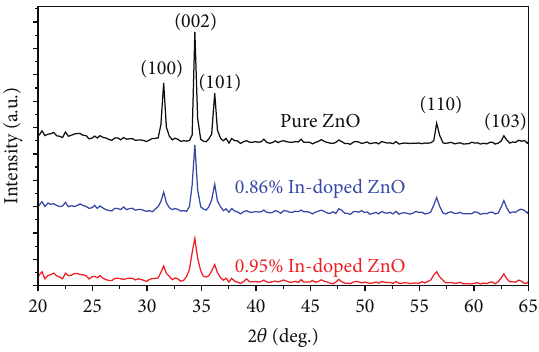
Figure 2: XRD patterns of ZnO and ZnO:In